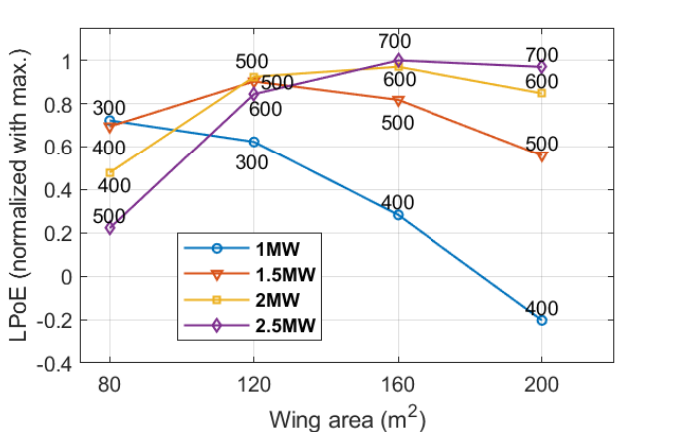
Figure 14. Maximum LPoE trend for the onshore business